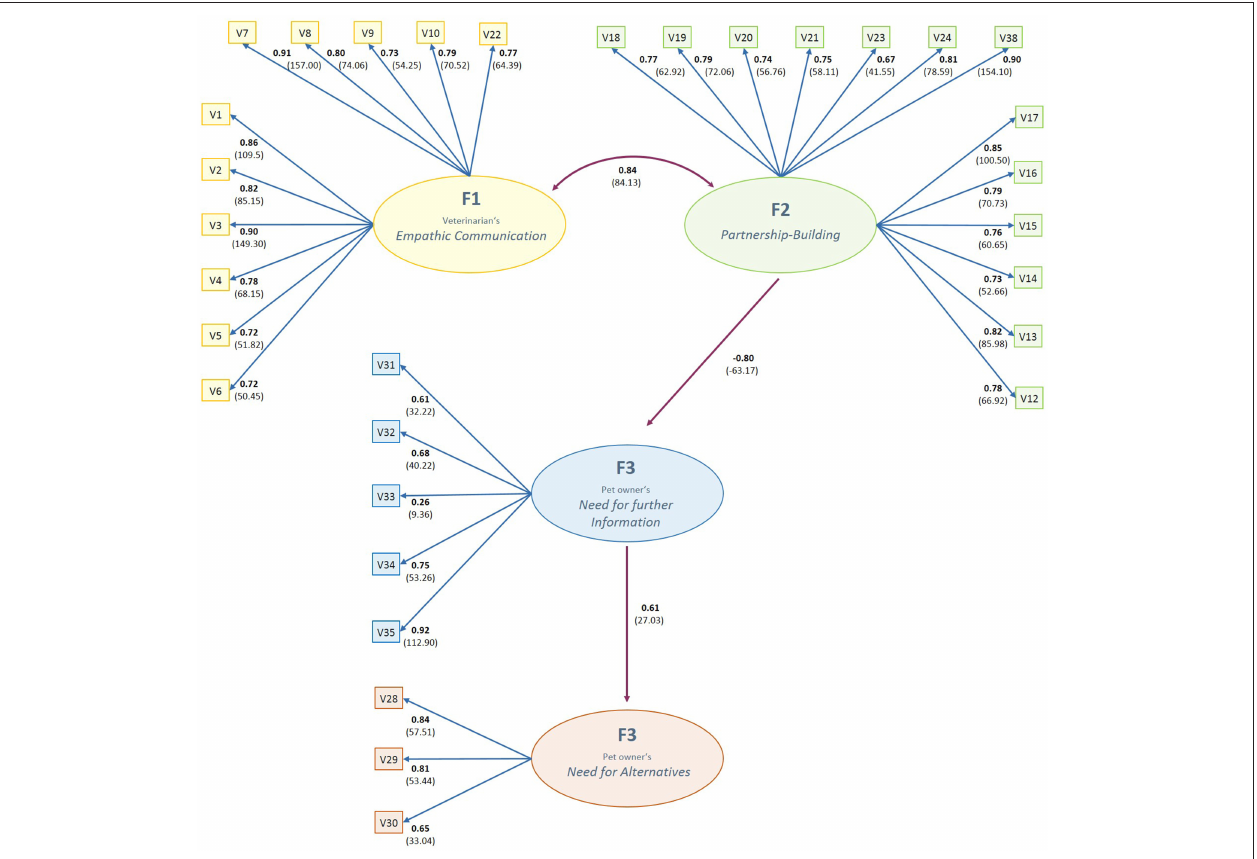
FIGURE 2 | Final structural equation model describing latent factors of pet owner’s perception of communication with their veterination. Association of latent factors and items described by path coefficients in bold and t-values in parentheses. F, latent factor; V, measurement item. Result based on 1,270 questionnaire